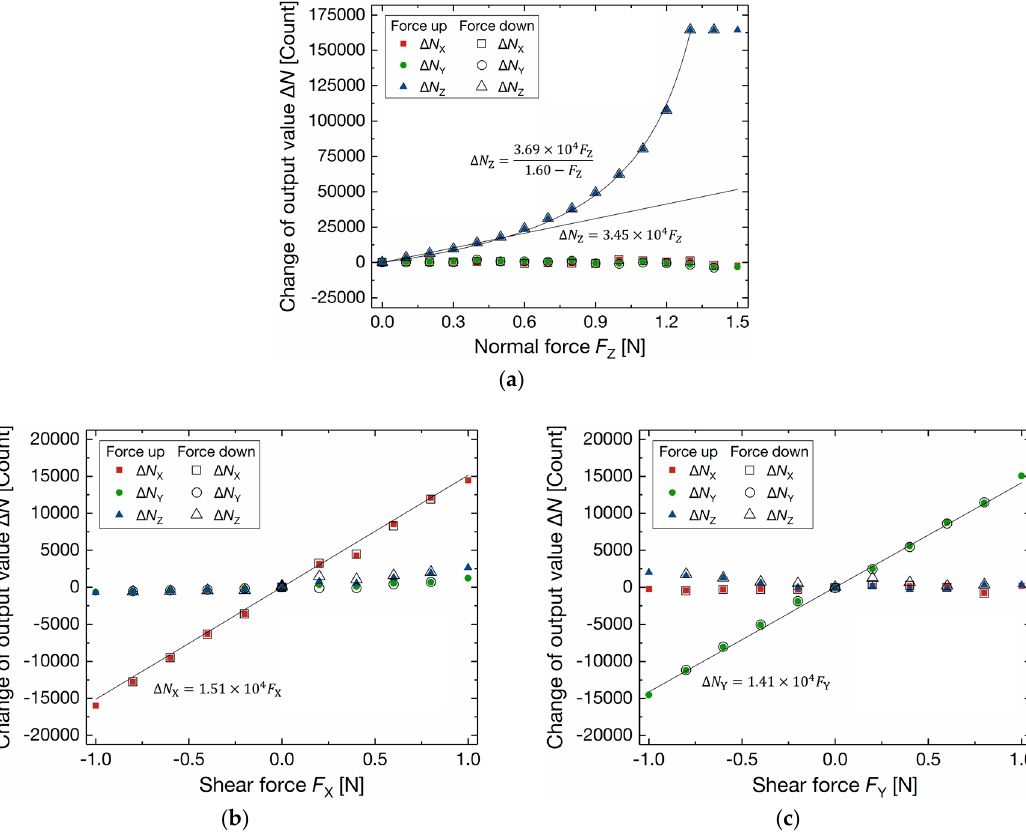
Figure 11. Change of output value of the 3-axis integrated tactile sensor by ( a ) normal force F Z ; ( b ) shear force F X and ( c ) shear force F Y .